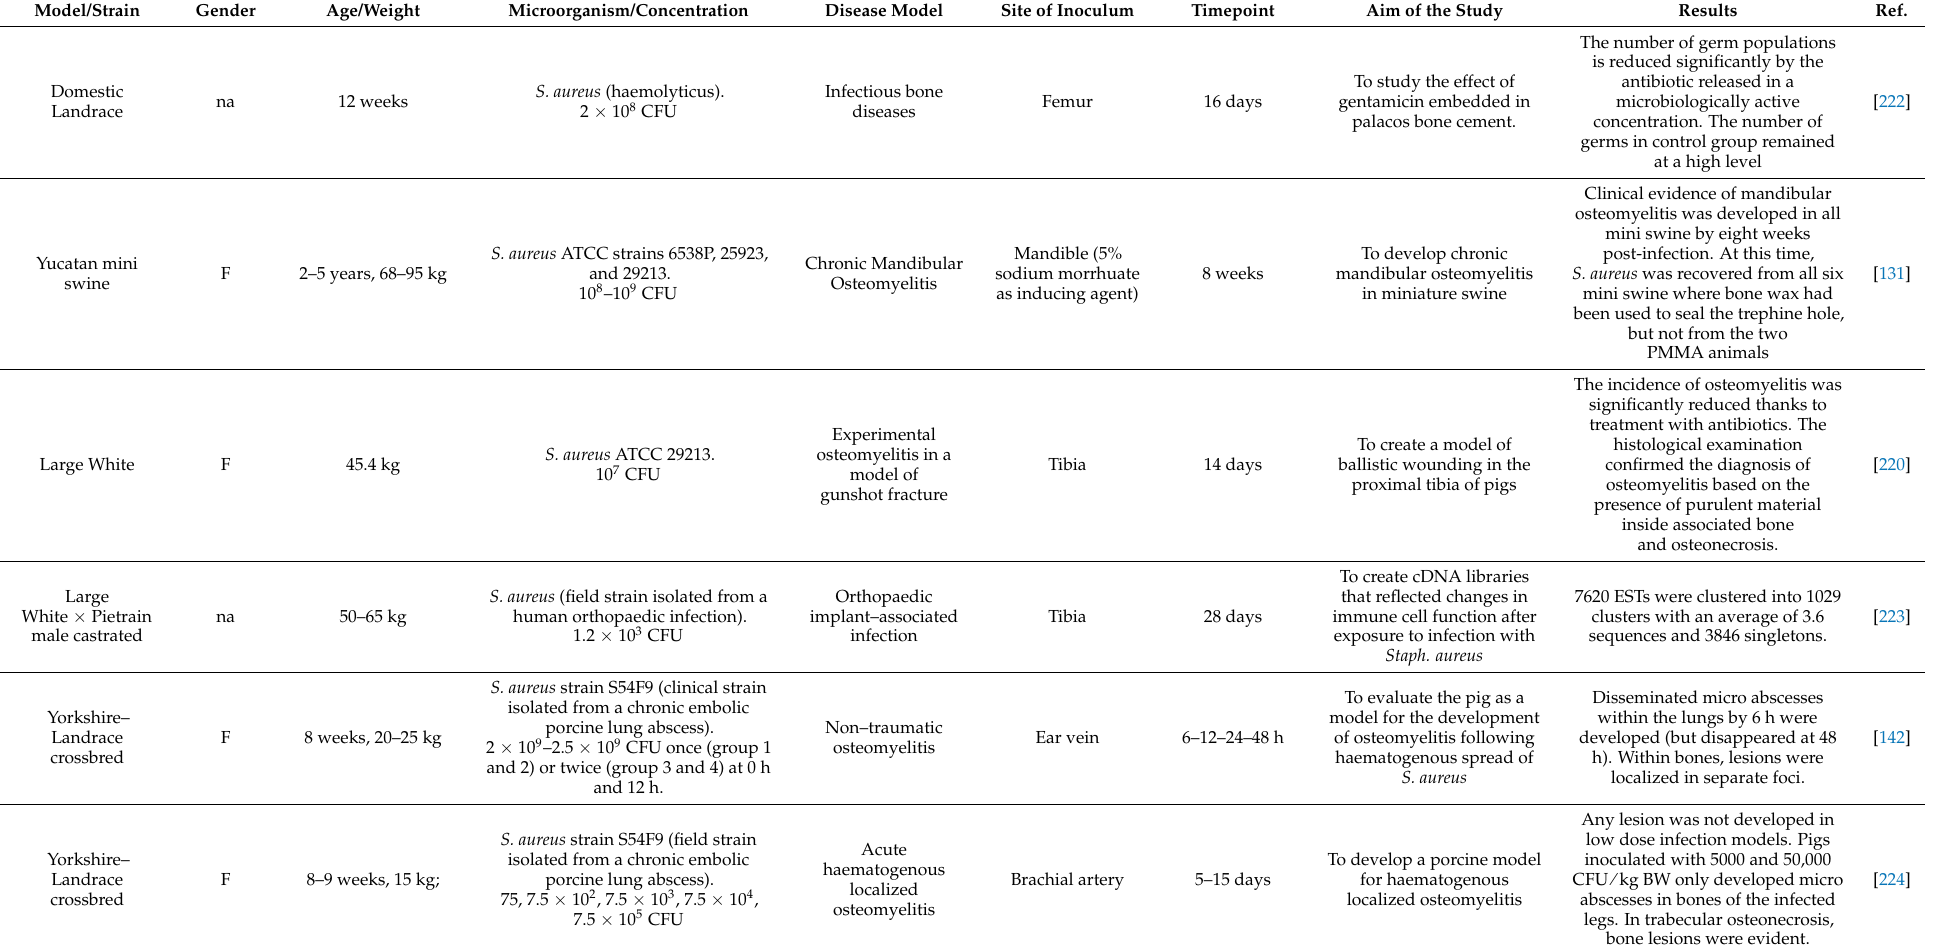
Table 7. Porcine models of orthopedic